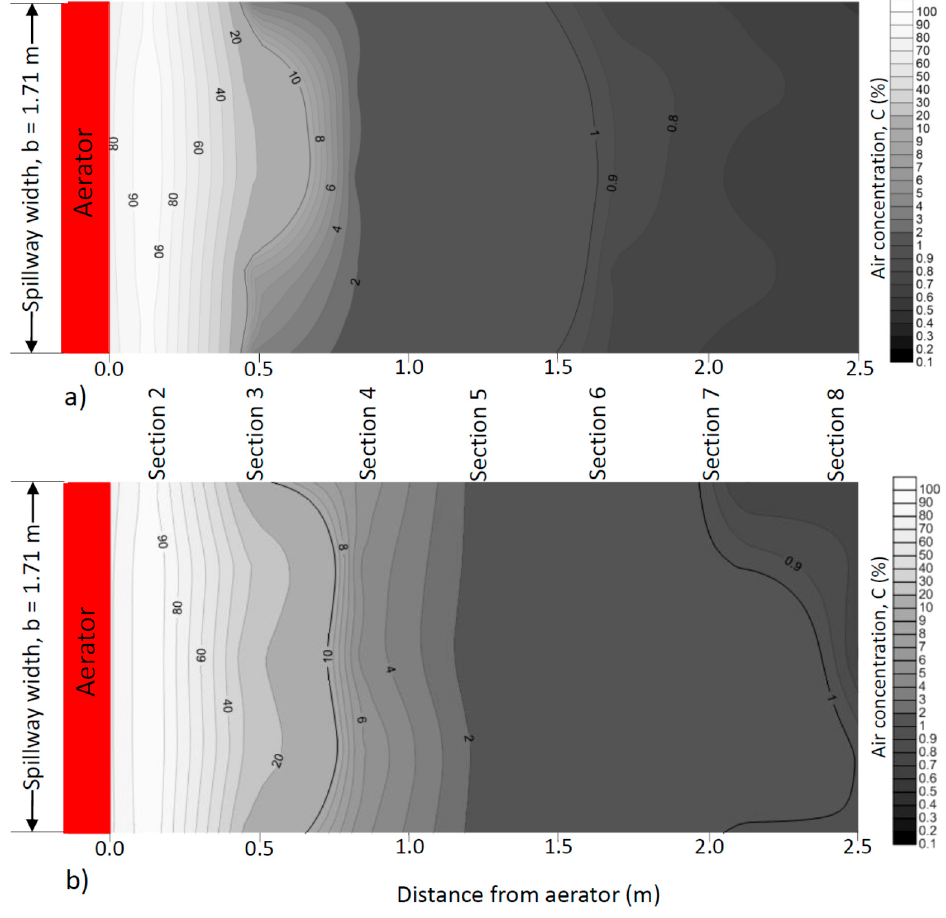
Figure 9. Bottom air concentration distribution for Q = 500 L/s ( a ) spillway without pier, ( b ) spillway with pier.